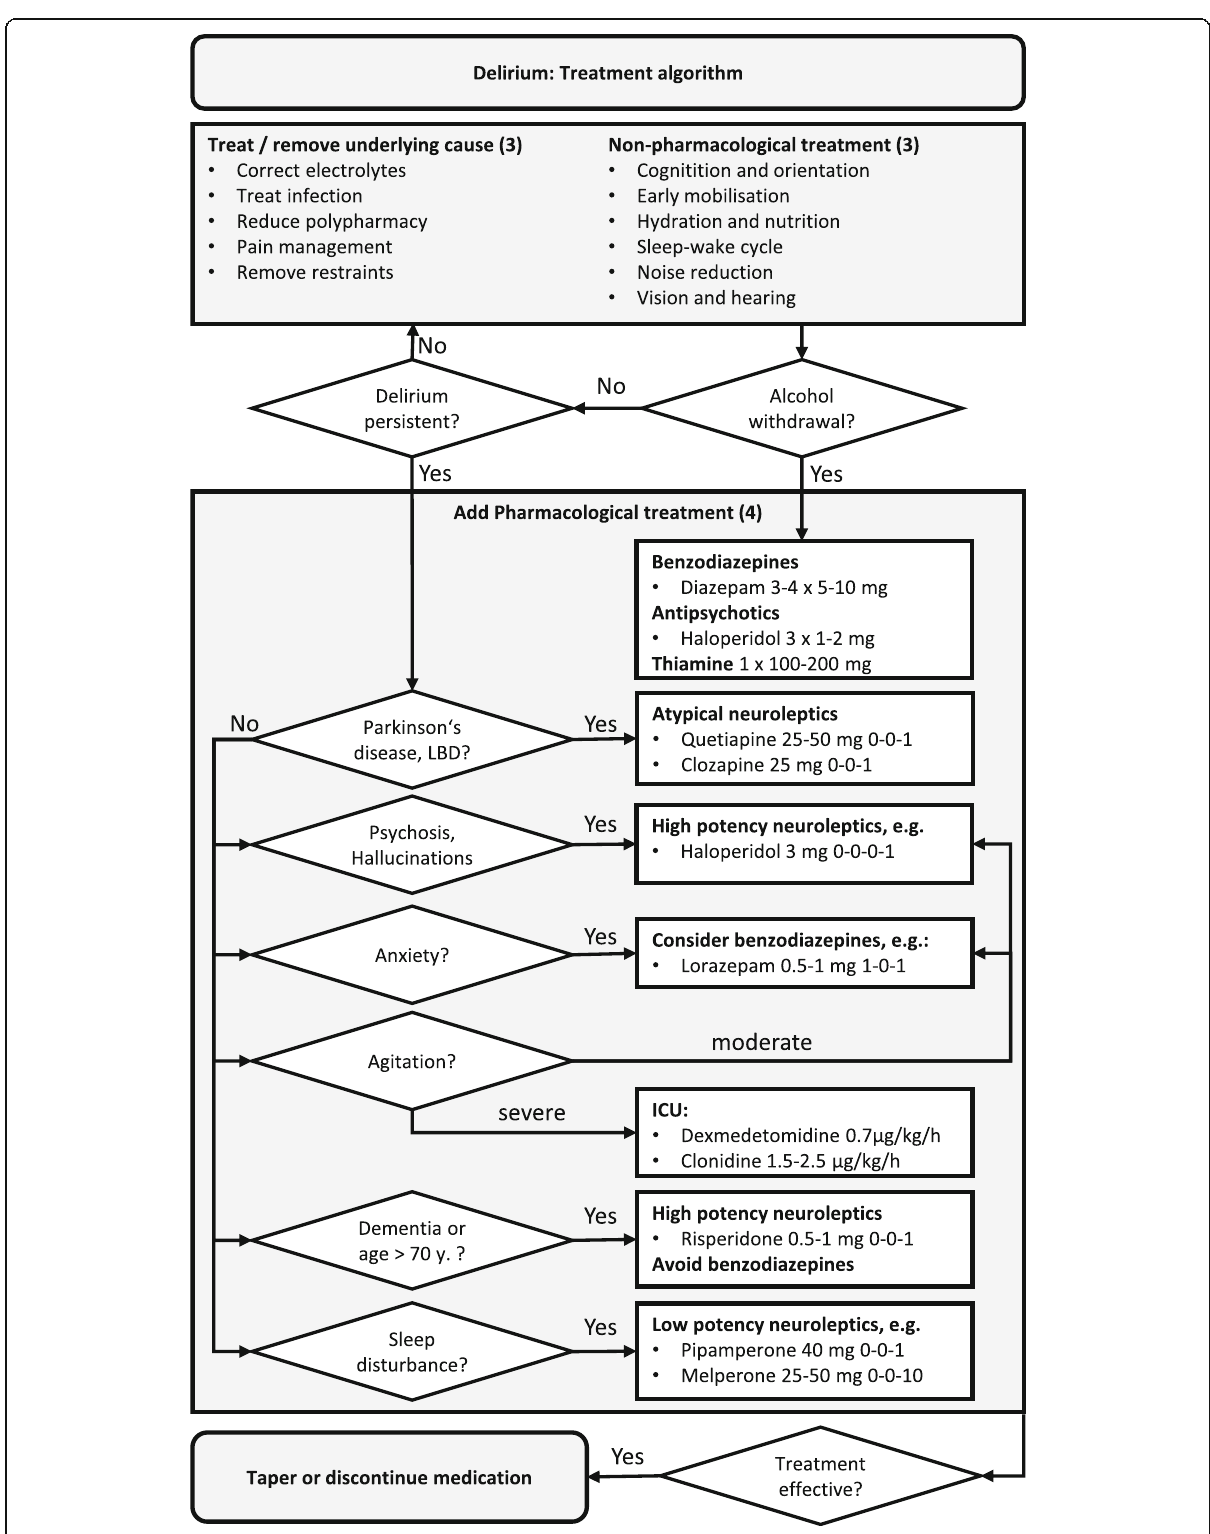
Fig. 2 Flow Chart for the therapy of delirium. ICU: intensive care unit. *Look for neurological signs and deficits including: meningism, paresis, pyramidal signs, sensory deficits, vision loss or deficits, ataxia, apraxia, nystagmus, cranial nerve deficits